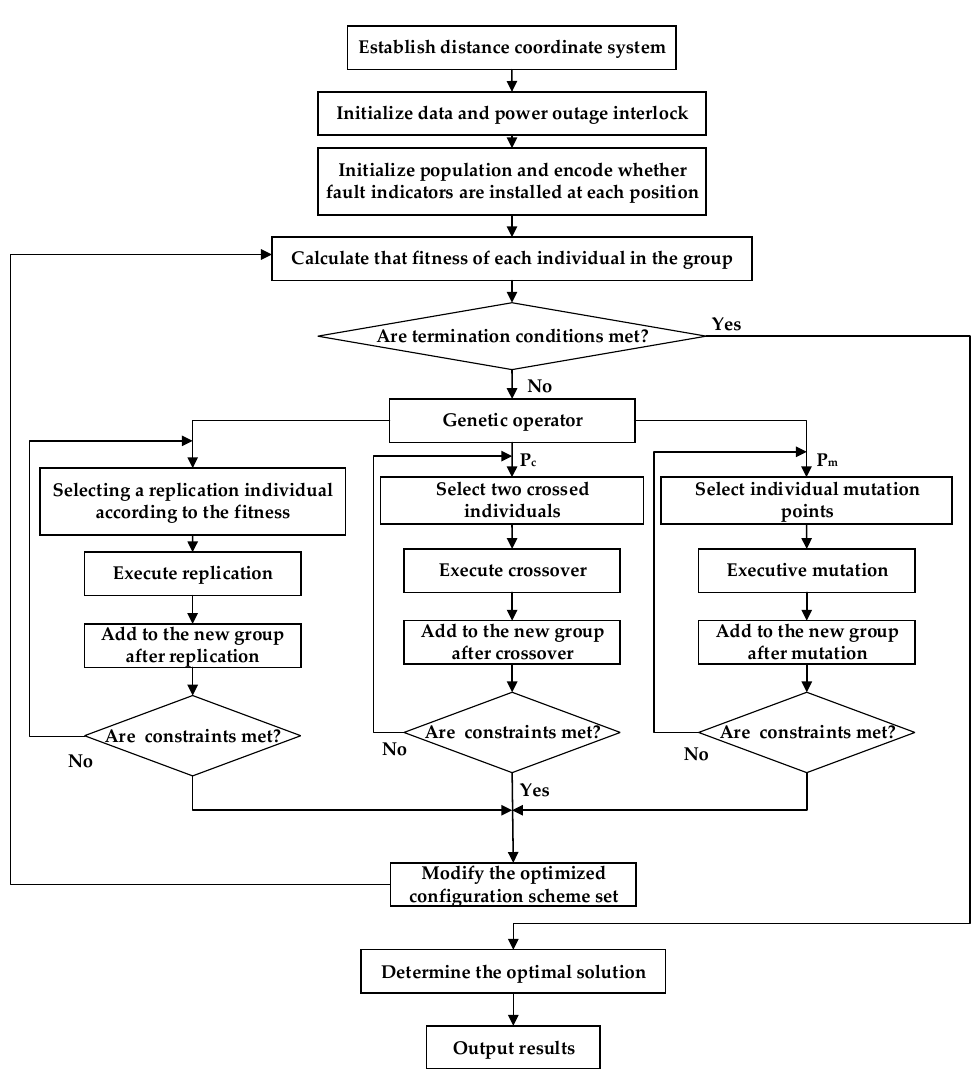
Figure 4. The flow chart of the proposed optimal configuration